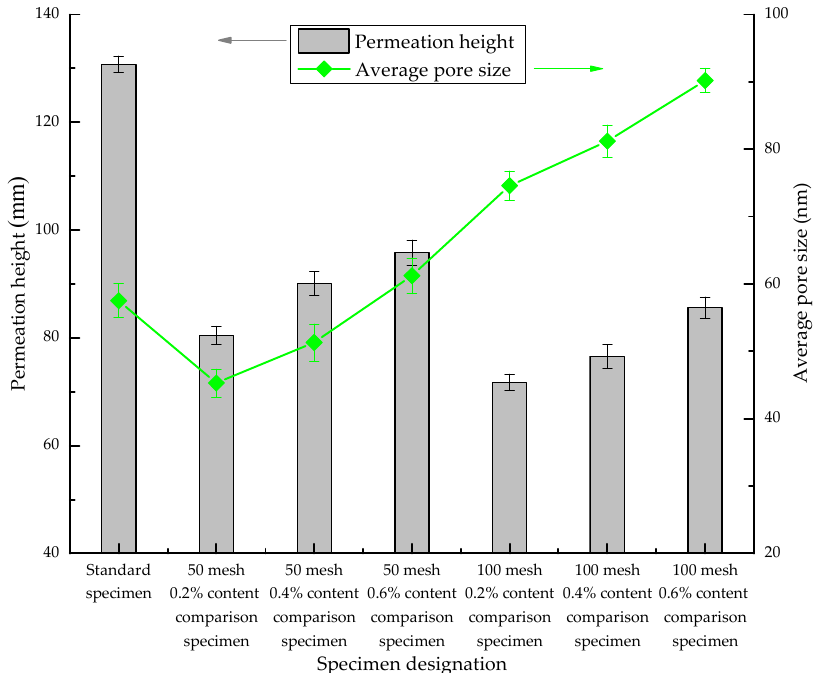
Figure 8. Comparison of the average pore size.